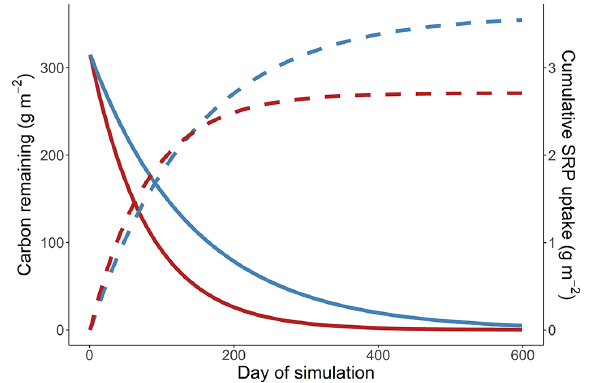
Figure A1. Simulation from a cold and warm scenario using a tem- perature dependence of respiration of 1.02eV, a temperature depen- dence of soluble reactive phosphorus uptake of 0.52eV, and a ref- erence rate of respiration increased to make the residence times of carbon more realistic. Mass of carbon (solid lines) and cumulative uptake of SRP (dashed lines) are presented over time for a 14 ◦ C (red) and 10 ◦ C (blue) temperature scenario.